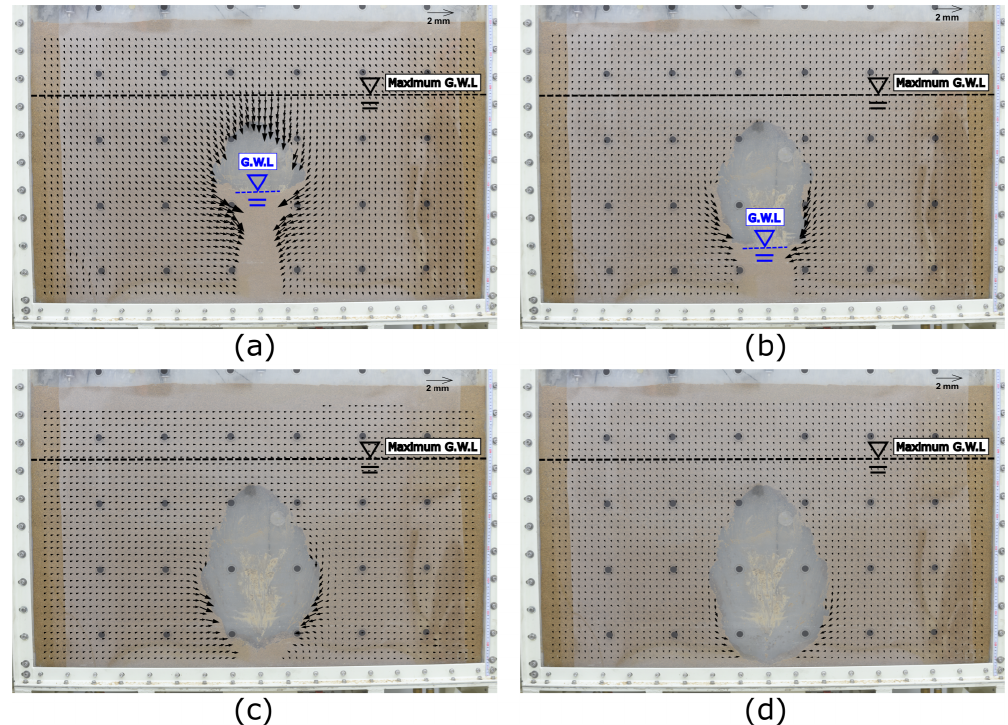
Figure 7. Displacement increment vectors inside the model ground for Test 2 during the water drainage stage: (a) 0–30s, (b) 30–60s, (c) 60–90s, and (d) 90–120s.